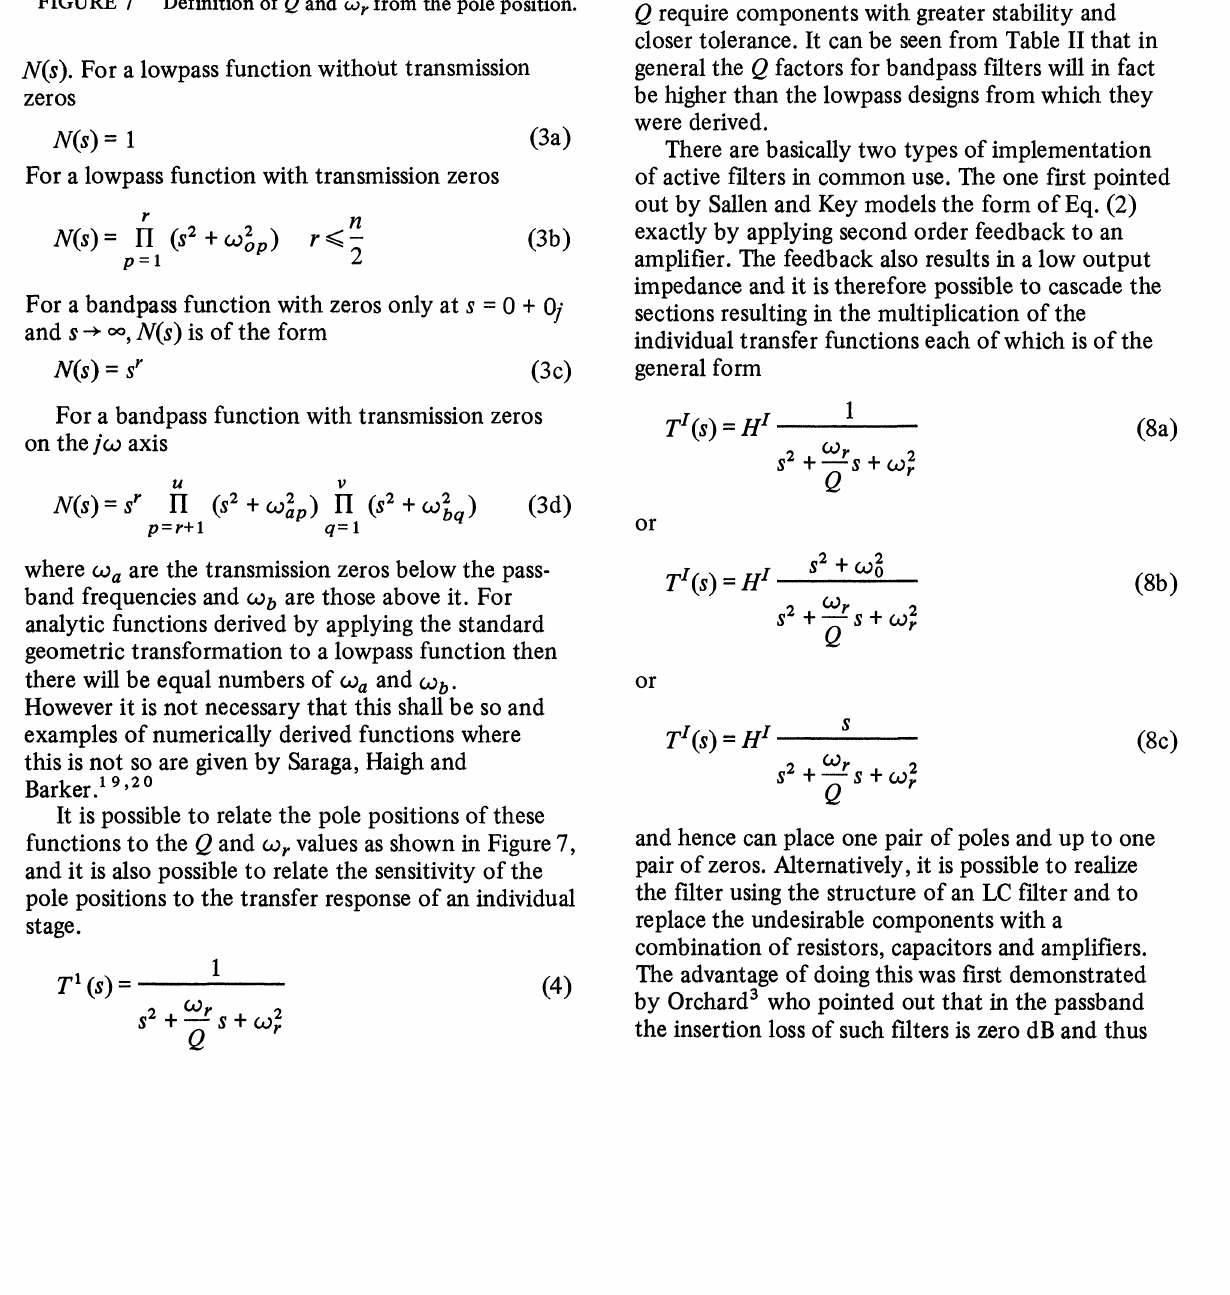
FIGURE 7 Definition of Q and w